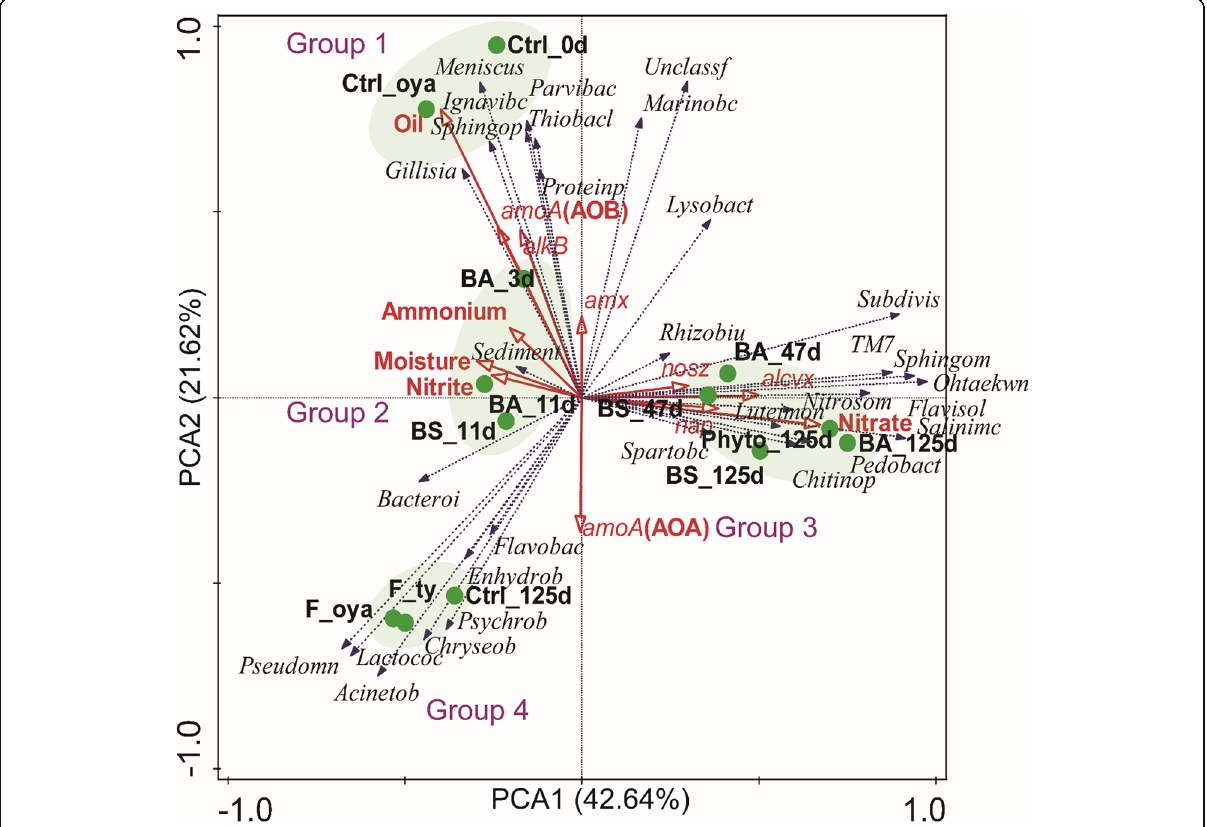
Fig. 7 PCA biplot analysis of samples and microorganisms (at the genus level). The green points represent the samples. The black rays with solid arrows represent the microorganism species. The red rays with open arrows represent the environmental factors, including the nitrogen and functional